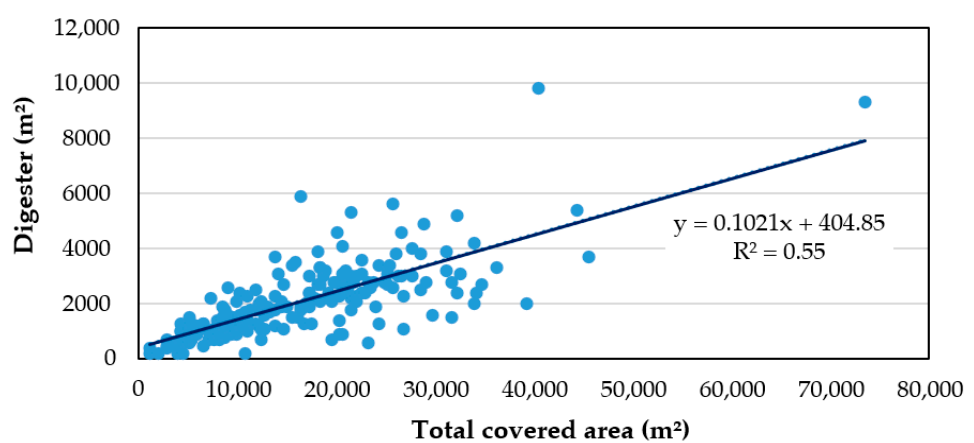
Figure 5. Correlation between digester facilities areas and total covered area.